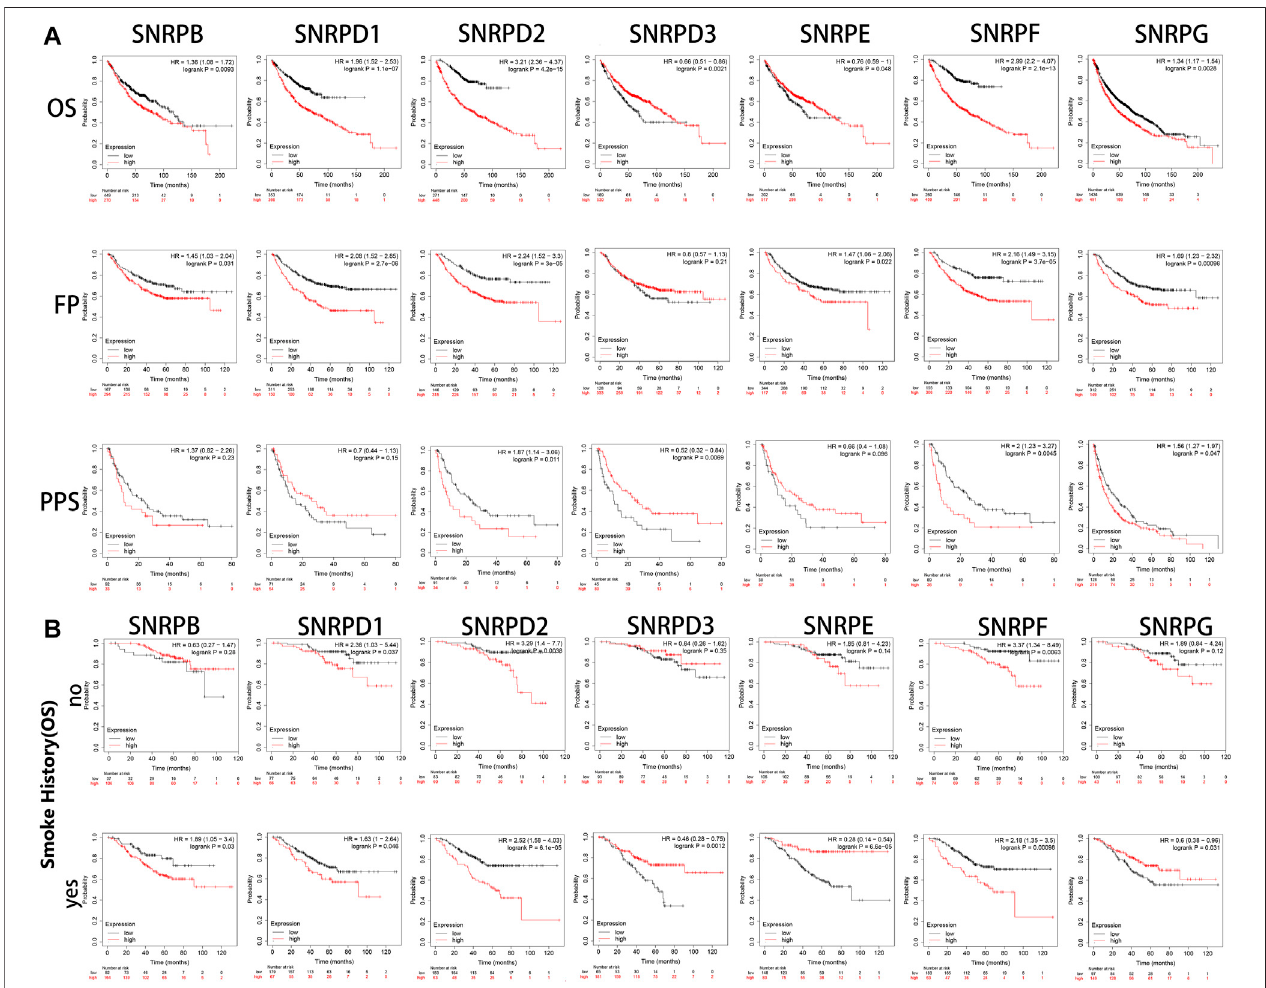
FIGURE5| ThesurvivalcurvesofLUADpatientswithgenesforSmproteinsandimpactsofsmokingonthesurvivalofthesepatients(Kaplan-MeierPlotter). (A) The Kaplan-Meier survival curves were used to evaluate the survival of LUAD patients with Sm proteins. (B) The effects of smoking in the OS of LUAD patients with Sm proteins. The log-rank test was performed in Kaplan-Meier survival analysis. A p value of < 0.05 was regarded as statistically signi fi cant. HR: hazard ratio.